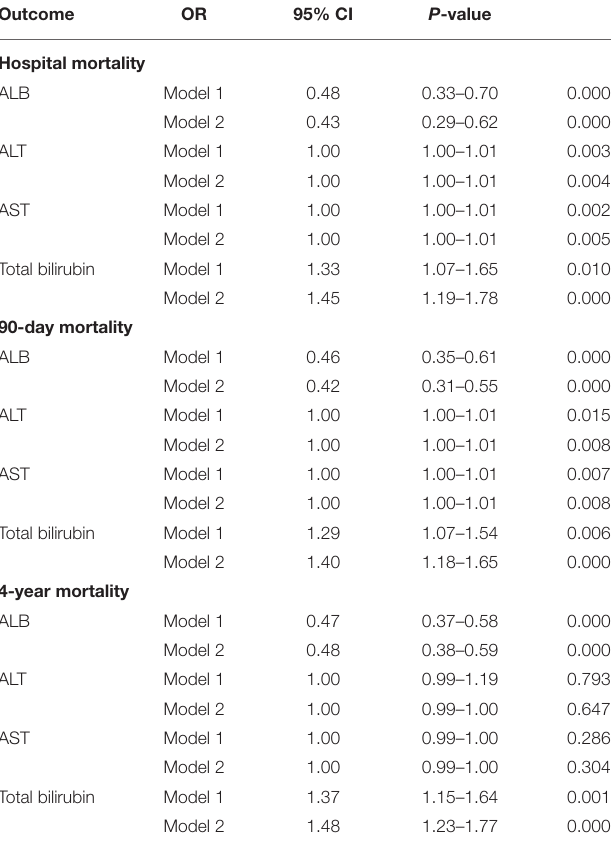
TABLE 7 | Association between ALB, ALT, AST, and total bilirubin with prognosis of cardiac surgery patients without liver disease.